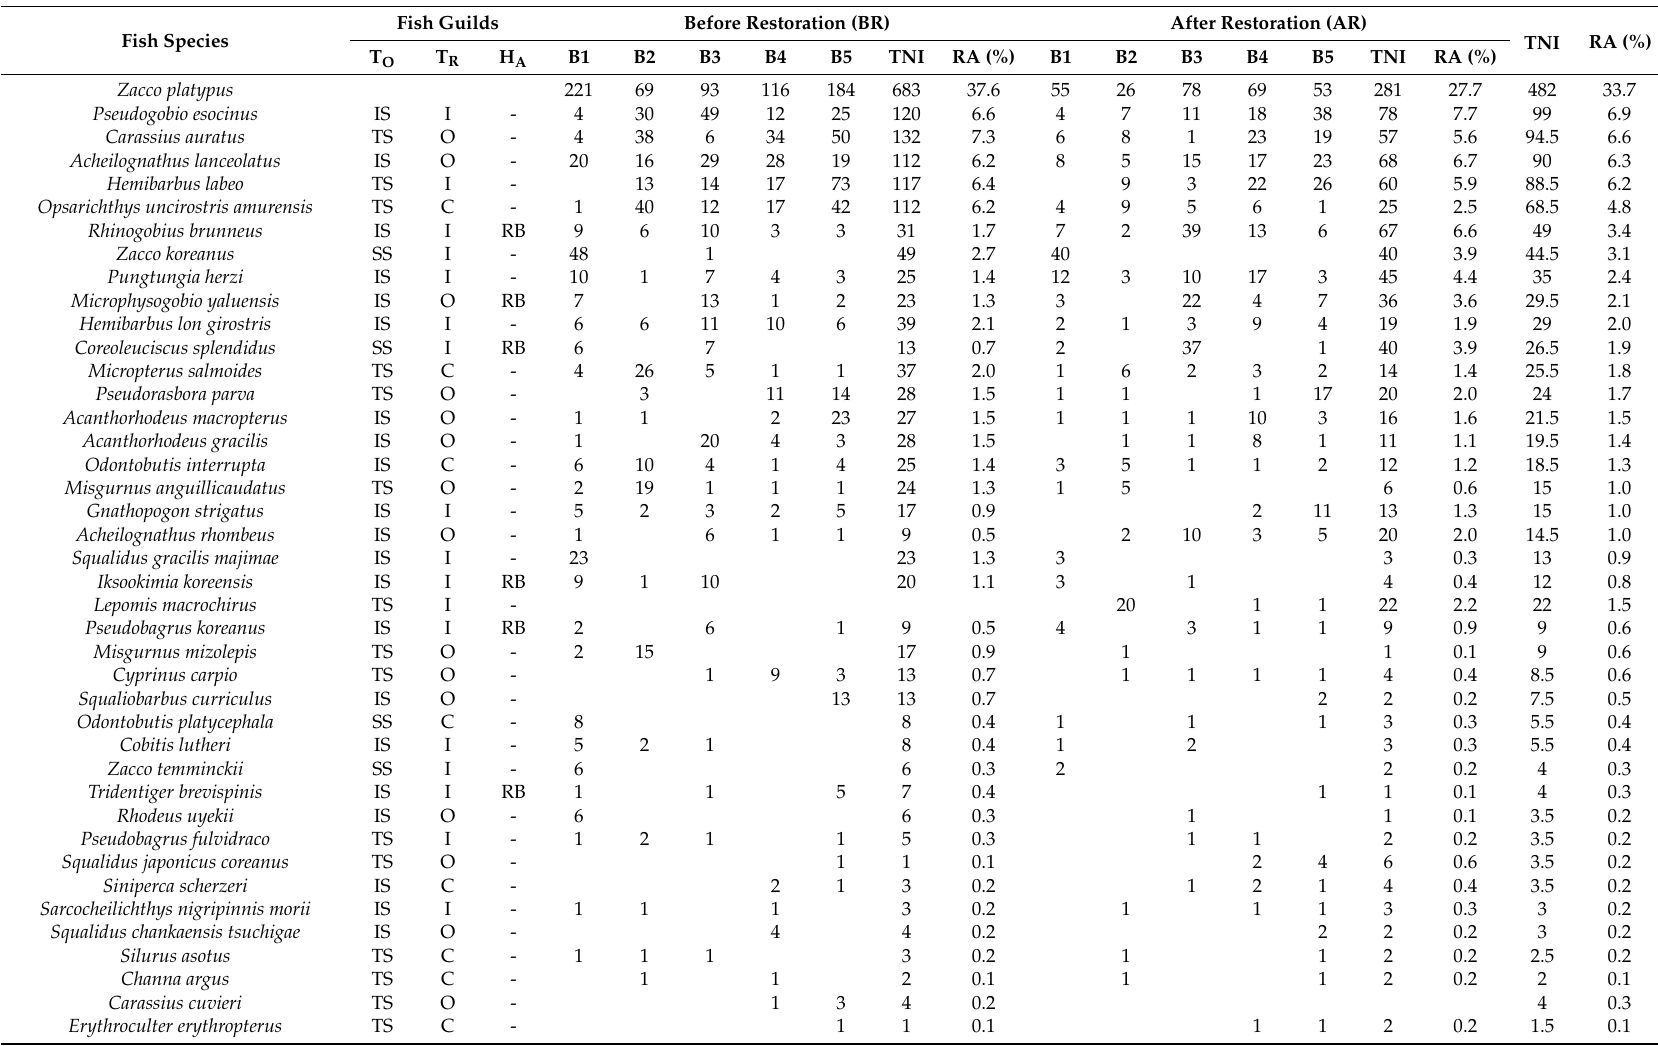
Table 5. Spatial distribution of fish species sampled from Gap Stream and their difference before and after